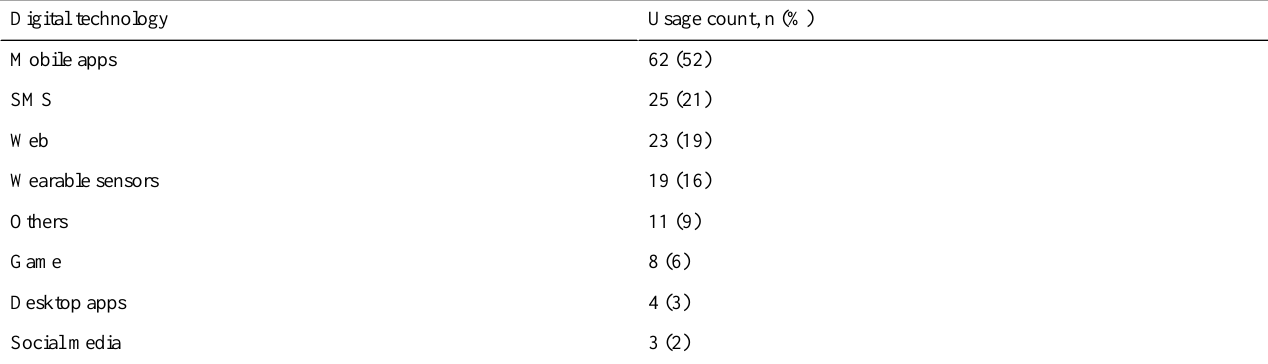
Table 6. Frequency of different technological platform used.